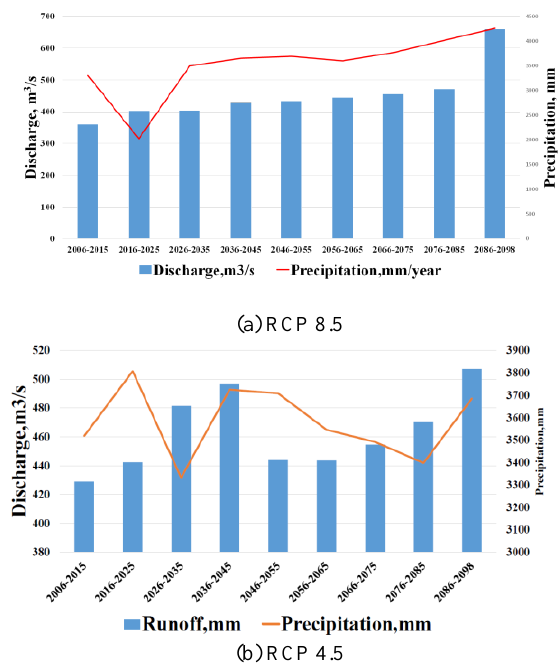
Figure 11. The trend of discharge at Pong Dam under each scenario